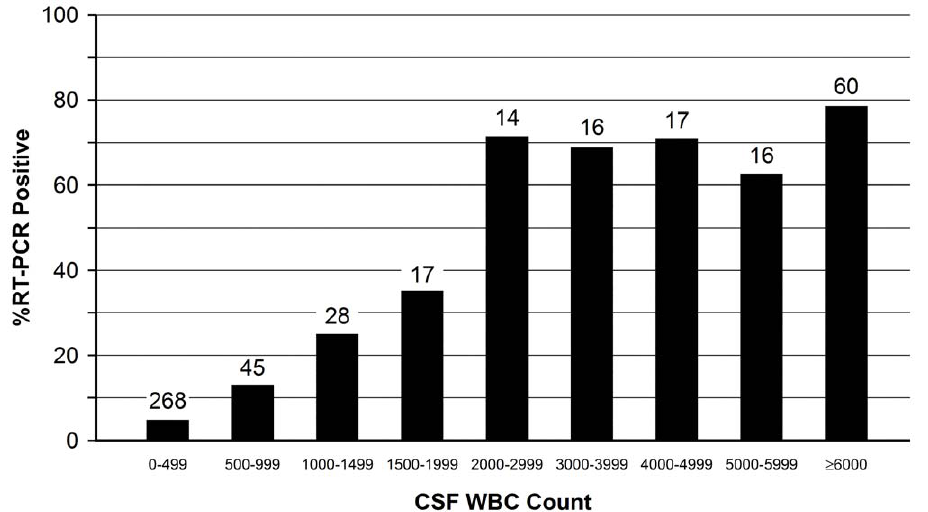
Figure 1. Proportion of culture-negative and culture-unknown 481 CSF specimens that were RT-PCR positive, by cerebrospinal fluid (CSF) white blood cell (WBC) count (leukocytes/mm 3 ). Numbers above bars represent the number of specimens tested. Includes 188 patients with unknown culture results.